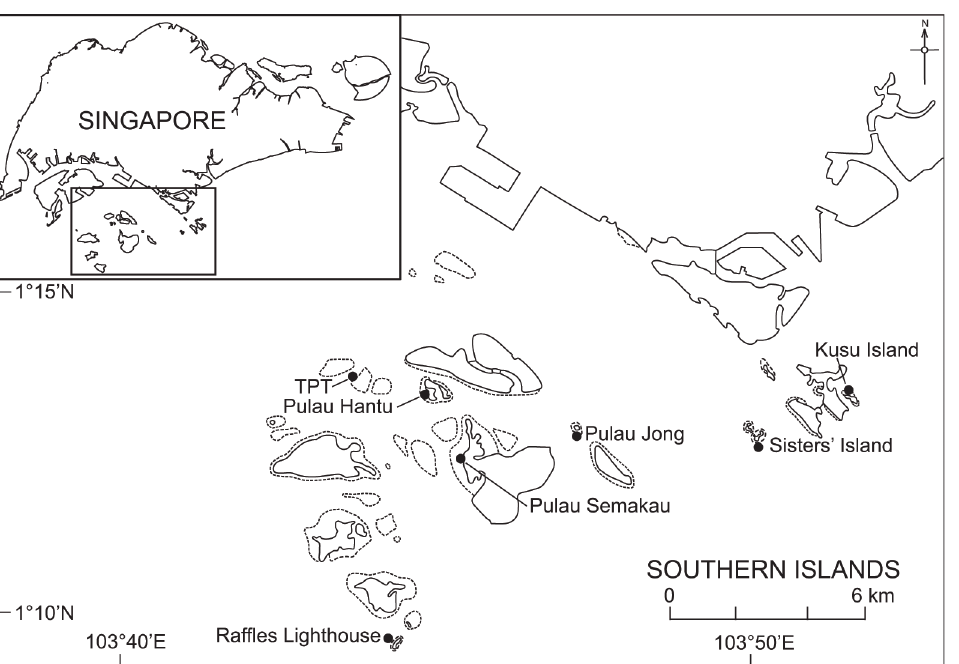
Fig 1. Map of southern coast of Singapore showing study sites. Sites are organized from west to east: Terumbu Pempang Tengah (TPT), Raffles Lighthouse, Pulau Hantu, Semekau, Pulau Jong, Sister ’ s Island and Kusu. Dotted lines represent fringing reef areas.